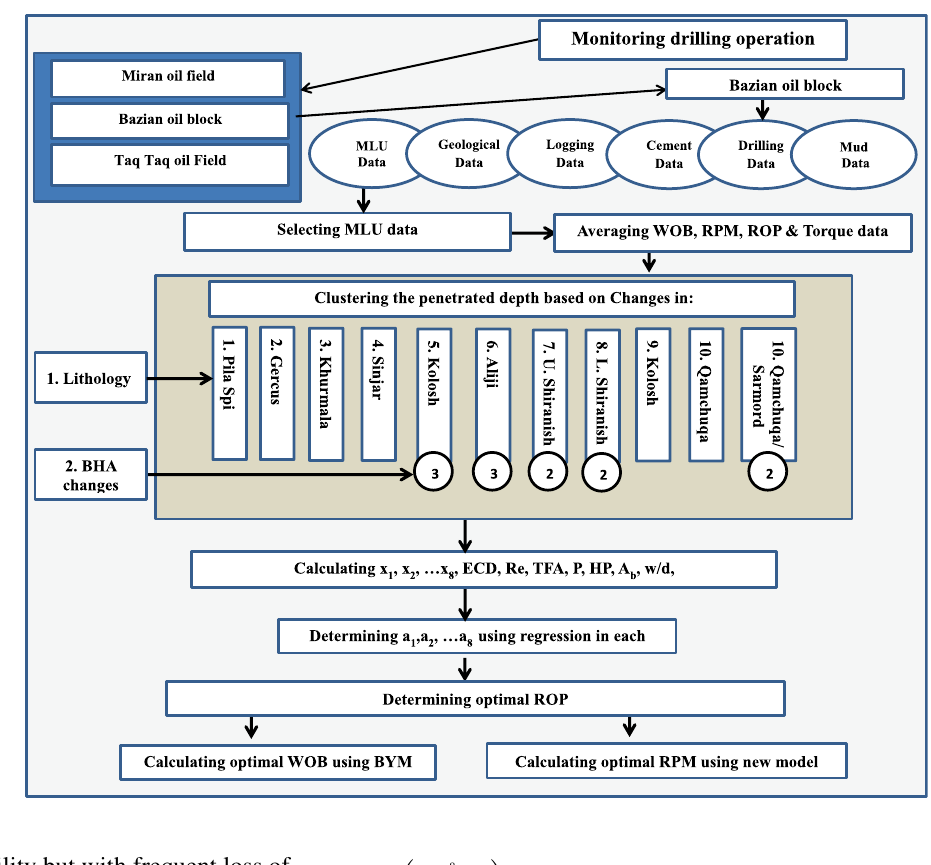
Fig. 1 Methodology